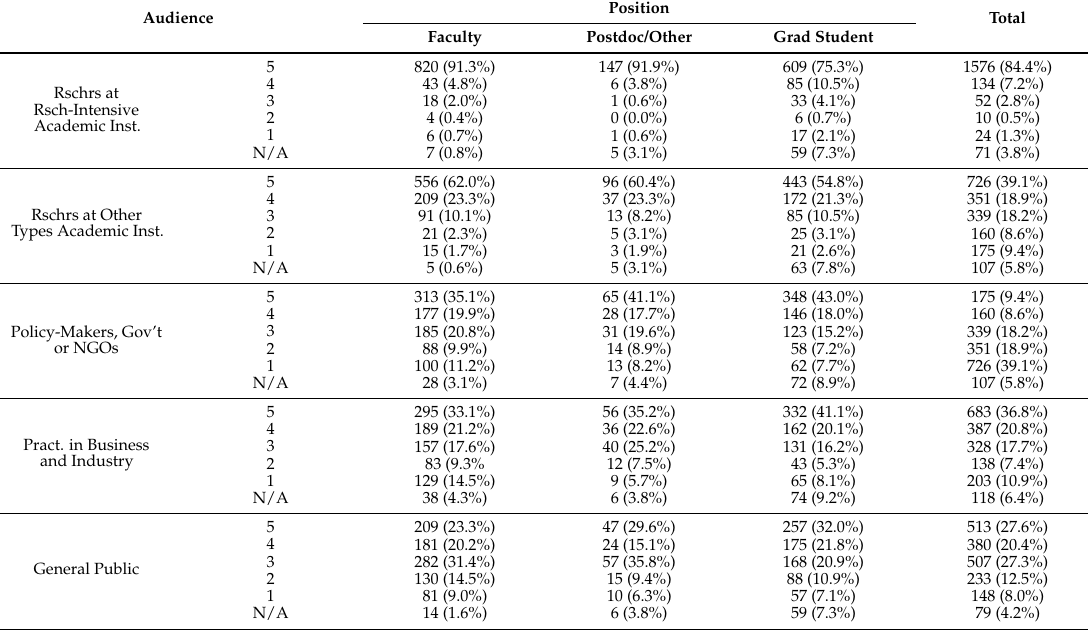
Table 13. Importance of accessibility for different audiences: percentage by